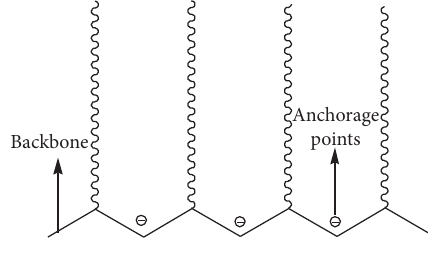
Figure 2: Structure of main chains of PCE. Figure 3: Complexation of Ca 2+ and